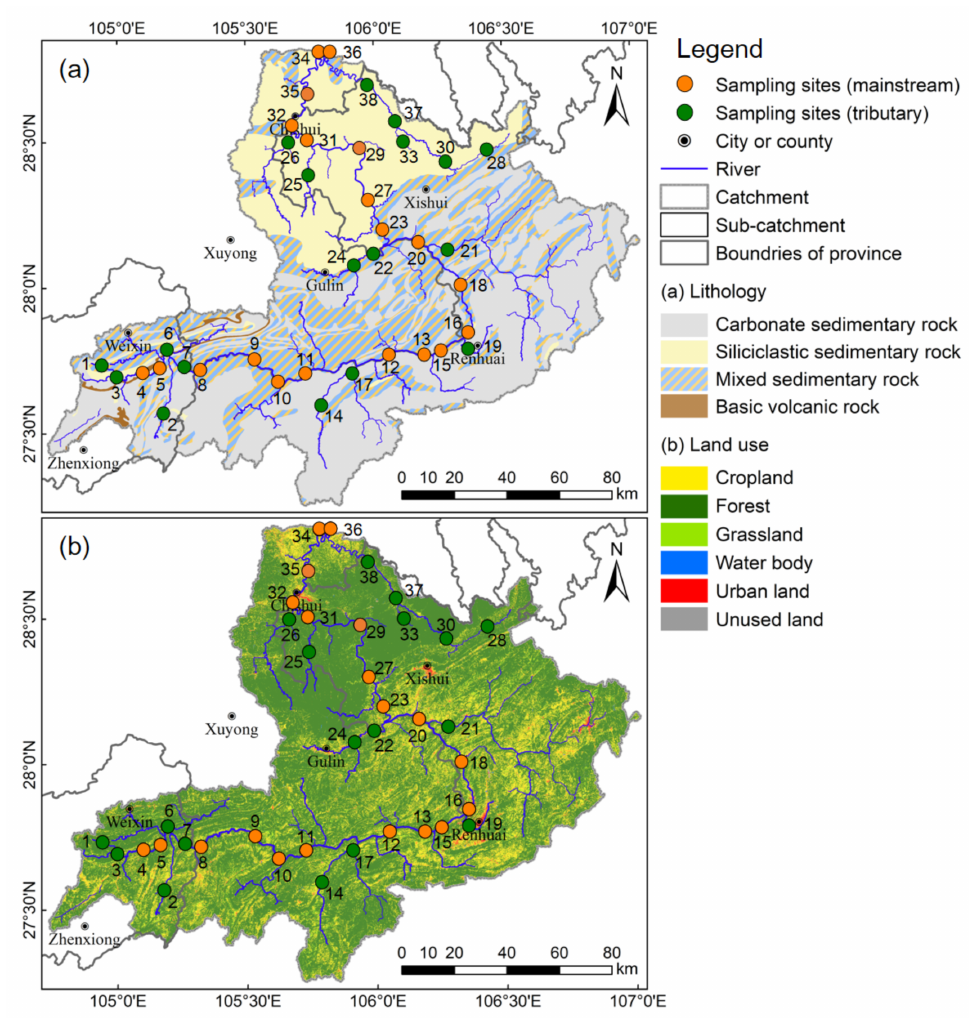
Figure 1. The background of sampling sites: ( a ) the lithology distribution of Chishui River watershed; ( b ) the land use of Chishui River